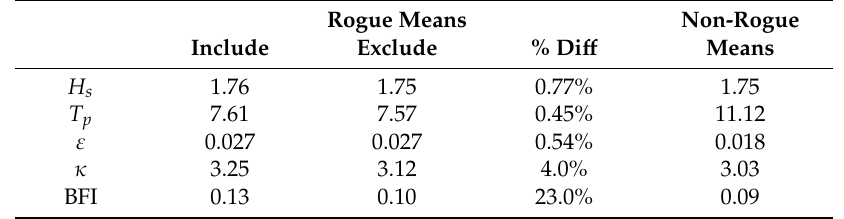
Table A4. Averages of wave statistics for rogue dataset, computed with identified rogues included / excluded, compared to mean values from non-rogue